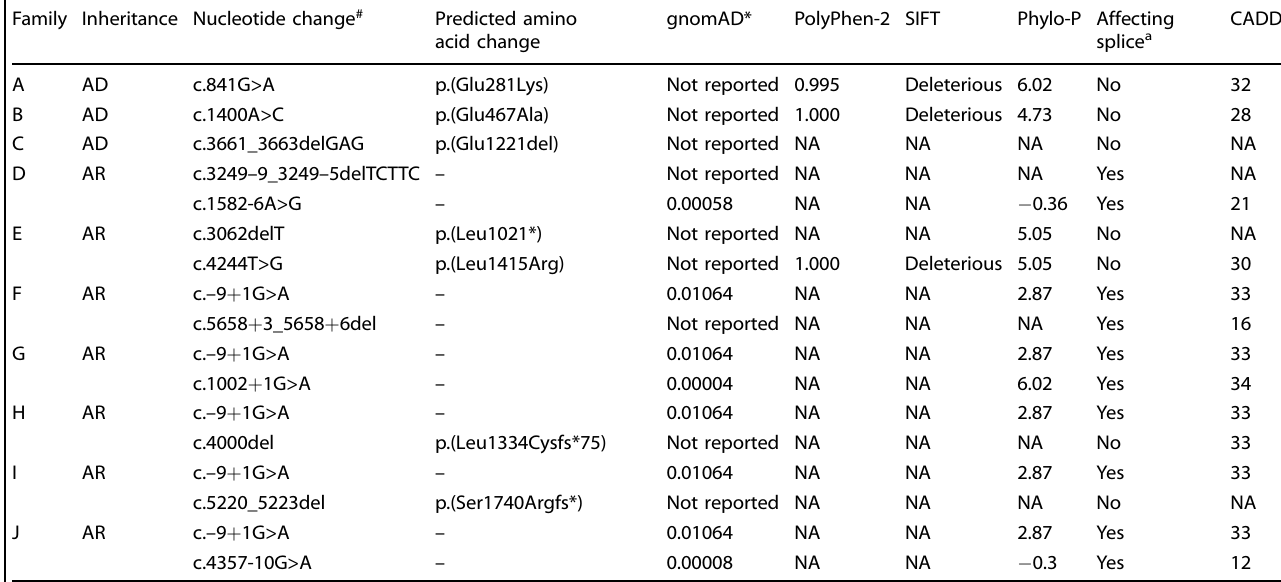
Table 2. Sequence variants in MYH3 , their frequencies in gnomAD and bioinformatic scores. Family Inheritance Nucleotide change